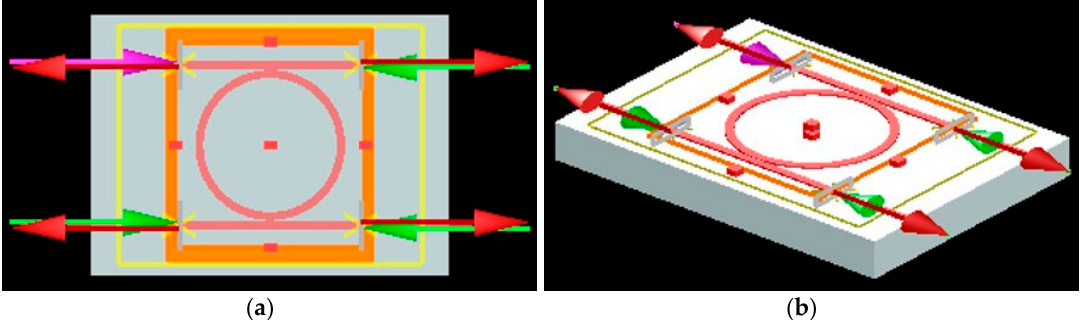
Figure 4. The geometry of the designed MRR in this simulation work from ( a ) top view and ( b ) bird’s- eye view.